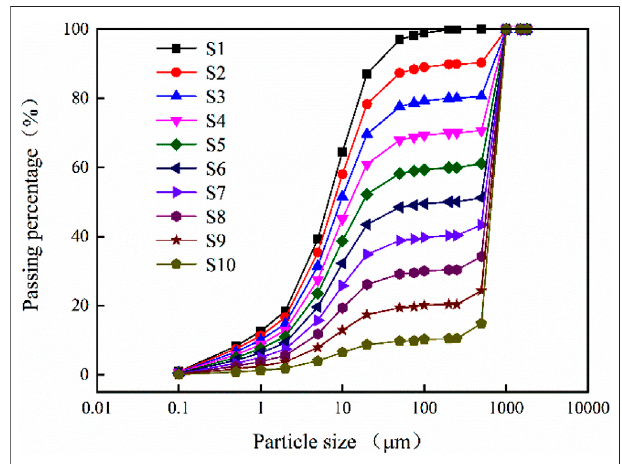
FIGURE 1 | Particle size